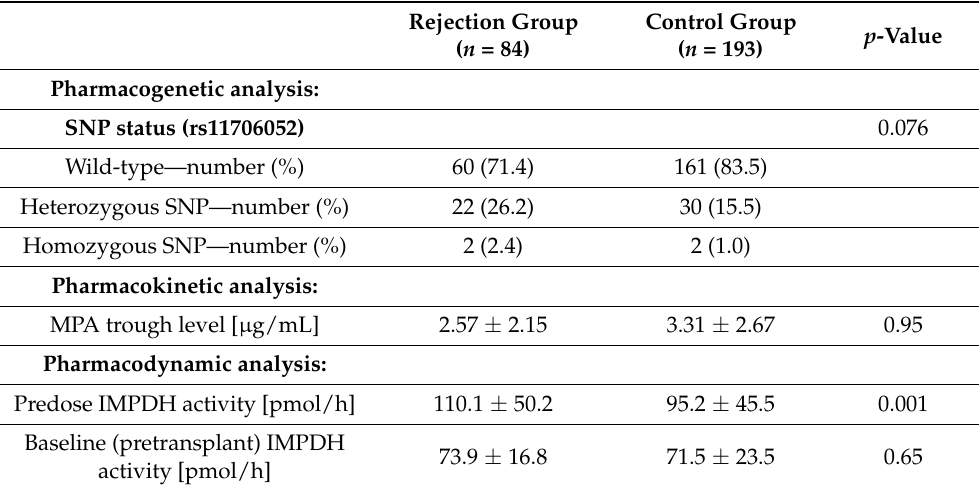
Table 2. Pharmacogenetic, Pharmacokinetic, and Pharmacodynamic Parameters in Kidney Transplant Recipients with and without Graft